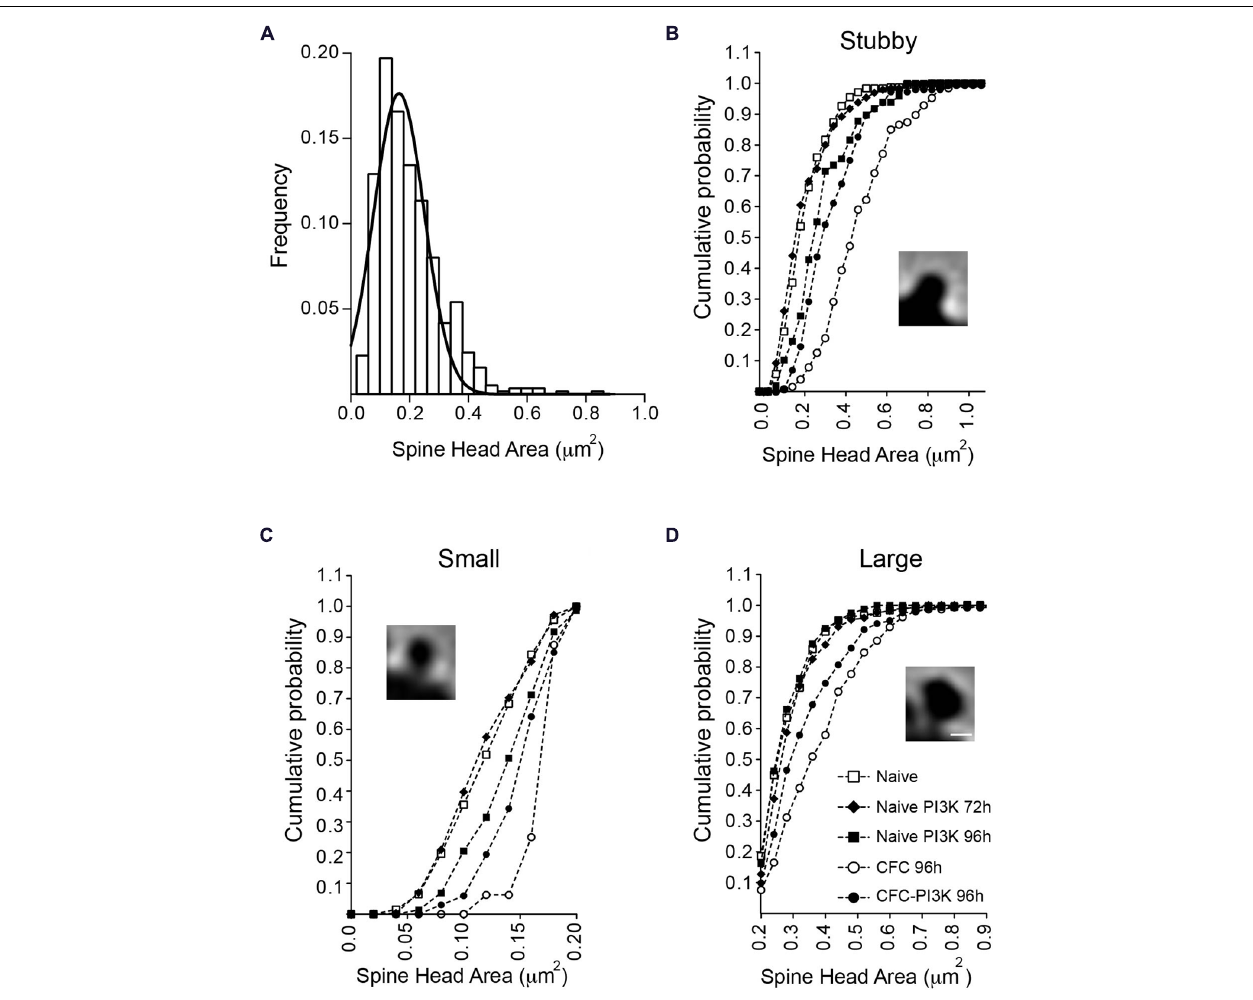
FIGURE 3 | Changes in spine head area are independent of spine morphology. (A) Normal distribution of necked spine head areas from the naive reference group (72 and 96 h combined). No-neck spines (stubby) were not included in this distribution. The mean spine head area of the distribution (0.19 ± 0.004 μ m 2 ) was used to further subdivide necked spines into small (below the mean) and large (above the mean) area spines. (B–D) Head area cumulative frequency plots for the different morphological spine types and experimental conditions. Naive animals